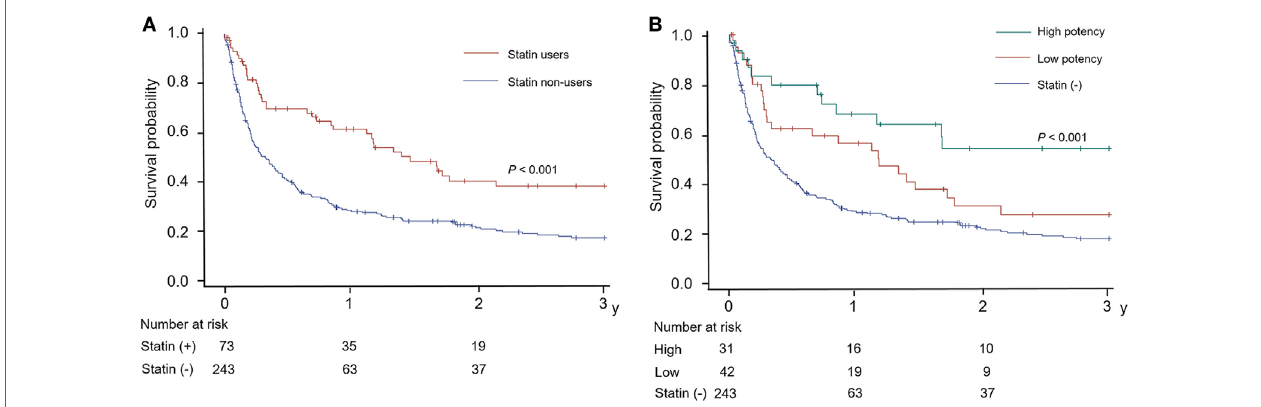
FigUre 3 | Kaplan–Meier’s curves for the survival according to (a) statin use and (B) the potency of statin used in patients with acute stroke and active cancer.